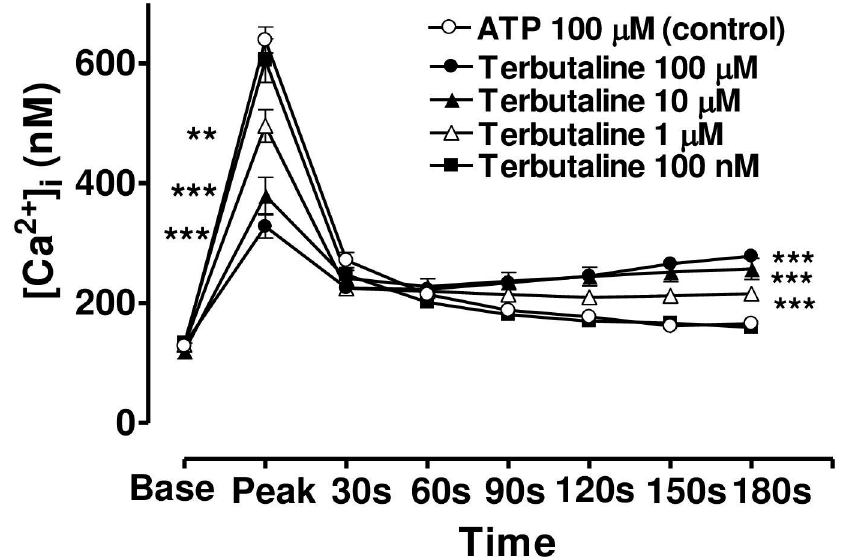
Fig 6. Effect of increasing concentration of terbutaline on the Ca 2+ -mobilizing response of ATP (100 μ M) in bovine cultured CE, both at the peak of the Ca 2+ transient and at selected time intervals thereafter. Cultured cells were incubated for 6 min with appropriate concentration of terbutaline in HEPES bufererd Krebs’ solution containing 1.8mM calcium. The cells were then exposed to 100 μ M of ATP. Each point represents a mean ± s.e.mean of 8–10 experiments. Significance of differences between incubations with or without terbutaline; �� p < 0.01 and ��� p < 0.001, Bonferroni’s multiple comparison test. Base value indicates the [Ca 2+ ] i prior to addition of ATP.